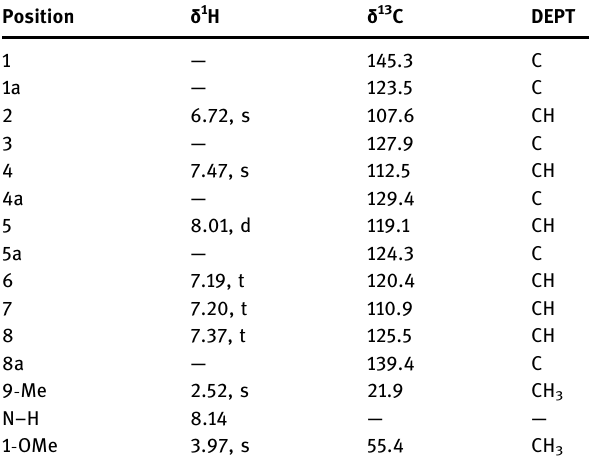
Table 1: NMR spectral data for